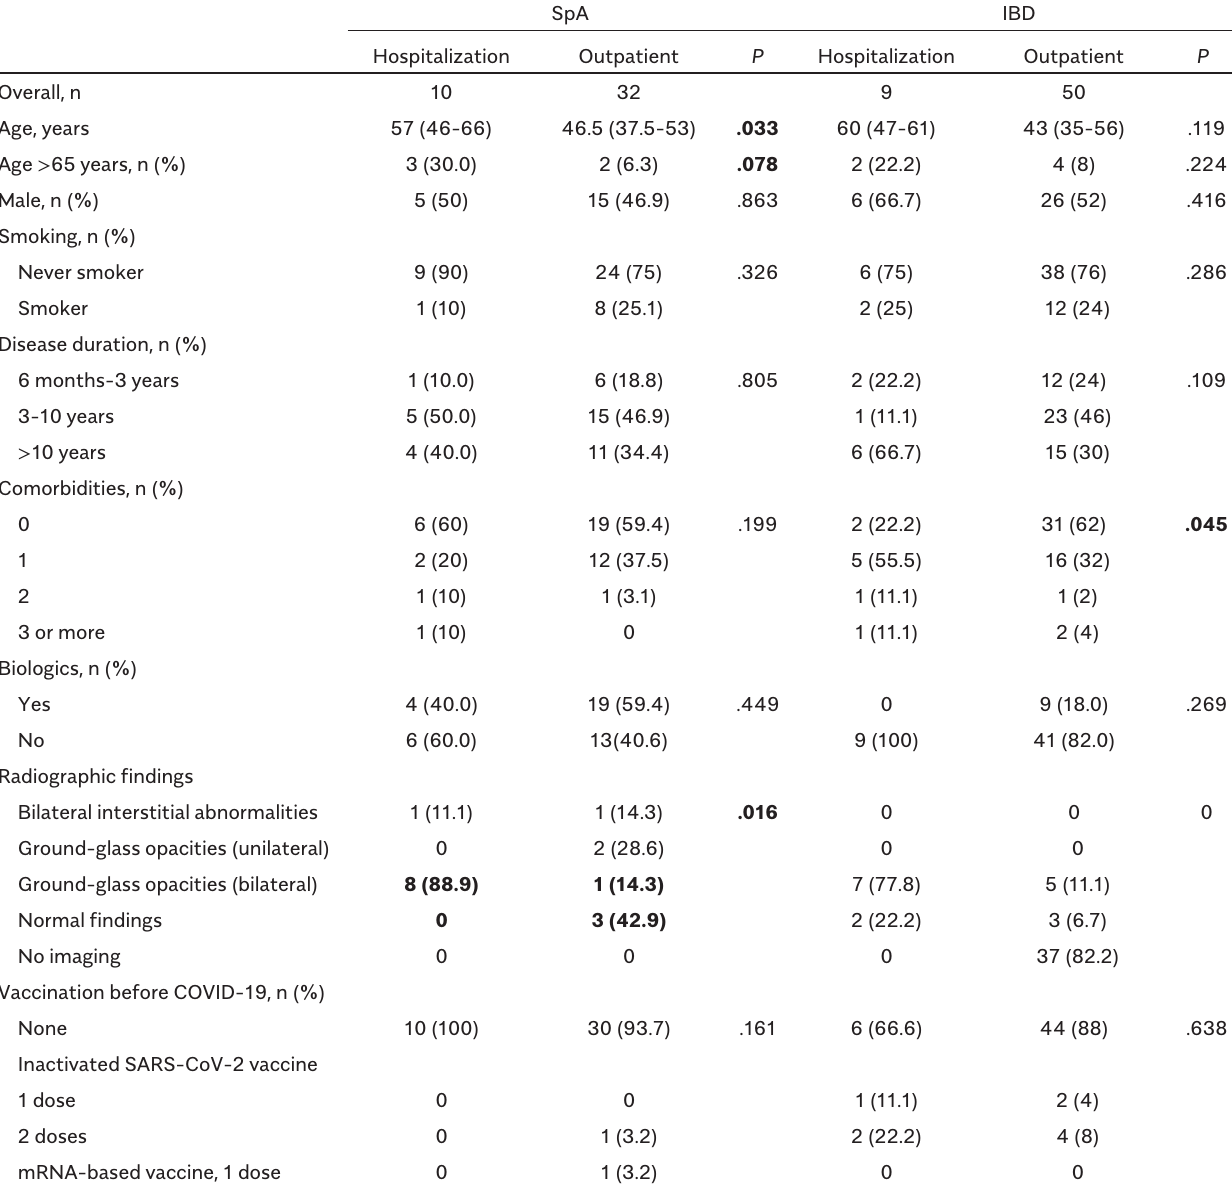
Table 3. Comparison of Baseline Clinical Characteristics and Outcomes of the Patients Infected with COVID-19 by Hospitalization SpA